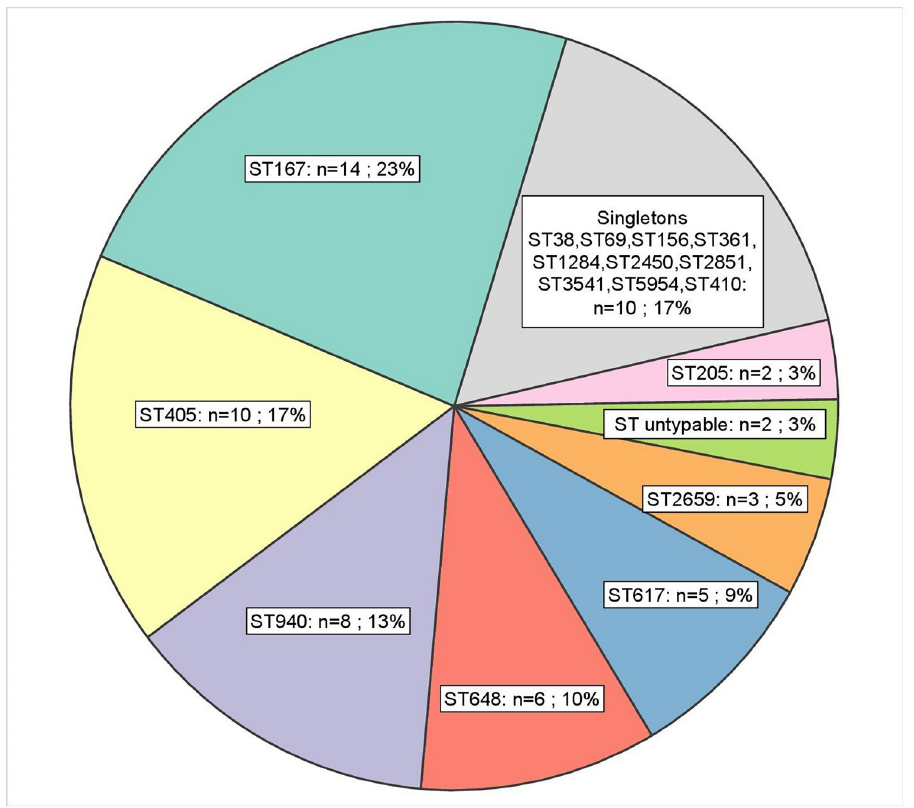
Fig 7. Pie chart of the sequence types (ST). The distribution of STs among carbapenemase-producing E . coli from the community.